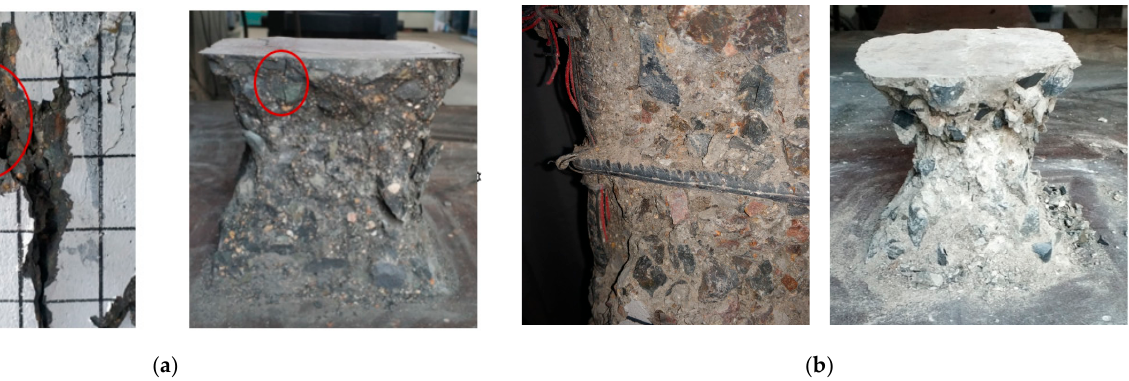
Figure 7. The aggregate failure mode of the specimens and blocks with different concrete strengths: ( a ) C100; ( b ) C50.